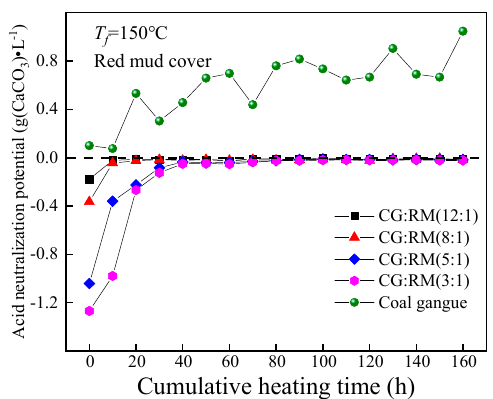
Figure 8. Variations of ANP of co-disposal leaching solution with different mass ratios.